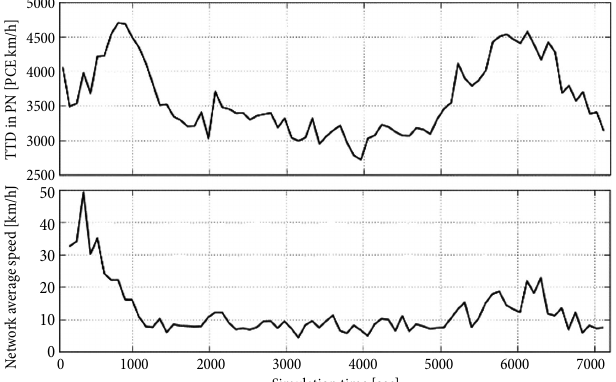
Fig. 6. Scenario 1: network performances